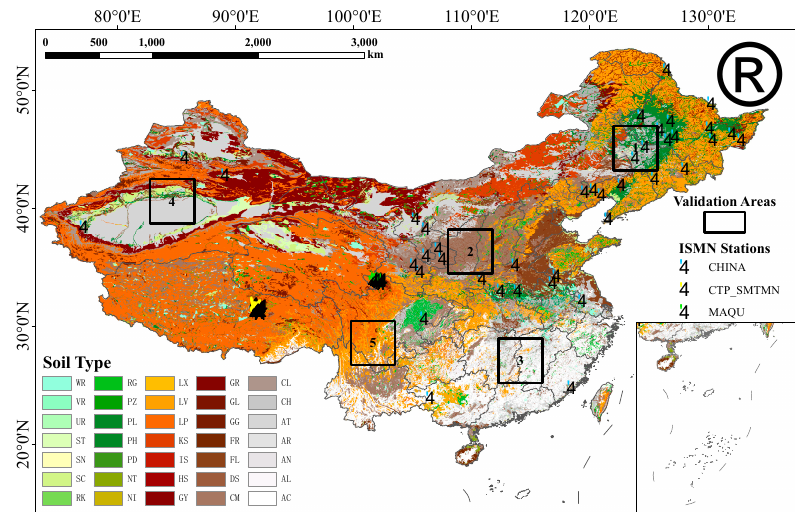
Figure 1. Spatial distribution of the study area where the background is soil type data. MAQU, CTP_SMTMN, and CHINA are three networks of in situ SM. Five black boxes are randomly selected areas for simulating data gaps. WR: Water Bodies. VR: Vertisols. UR: Urban. ST: Salt Flats.